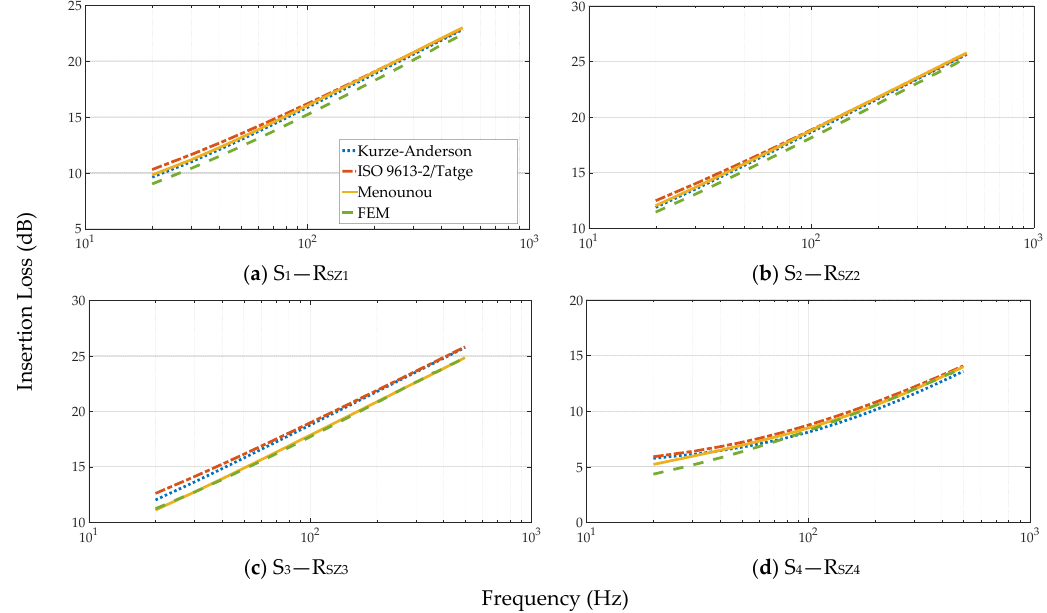
Figure 6. Comparison of insertion loss results between FEM and various formulae for various source and receiver positions in the shadow zone.